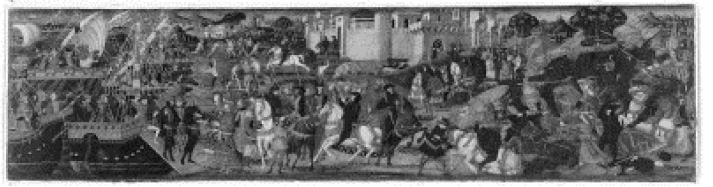
Figure 4. Paolo Uccello. Trojans Land in Latium and the Battle of Camilla, Turnus and the Trojans . c.1470. Seattle: Seattle Art Museum, Samuel H. Kress Collection, 61.173.